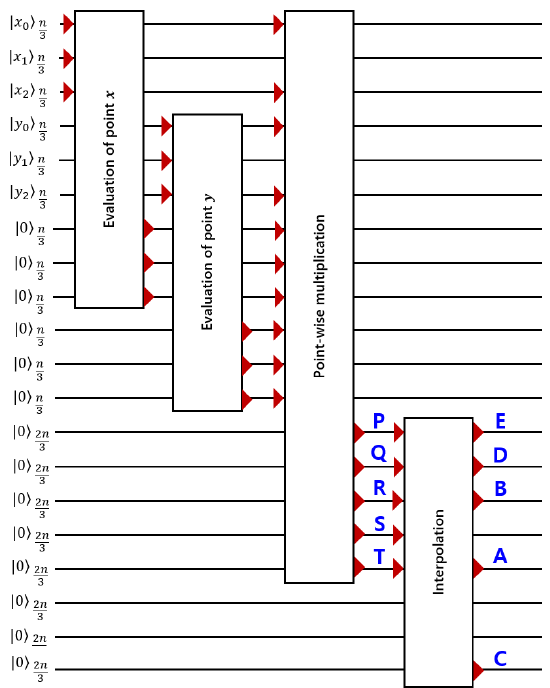
Figure 2. Overall Quantum Circuit for Toom-3 Multiplication.